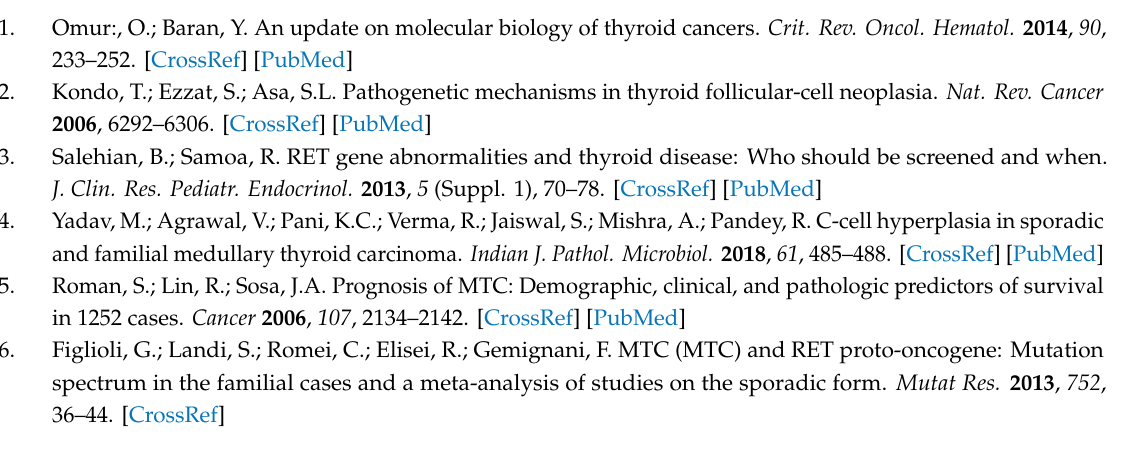
Table S1: Case series under